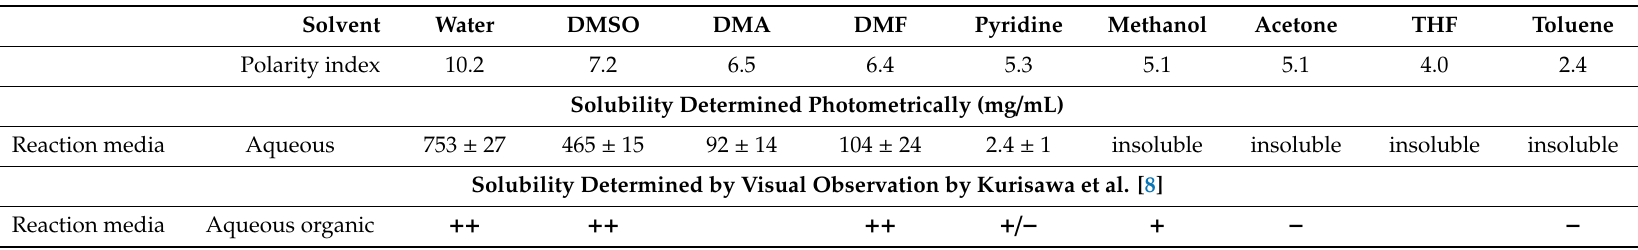
Table 1. Solubility of polyrutin (PR) synthesized in water media and PR synthesized in aqueous organic media [8] in solvents with a di ff erent polarity index